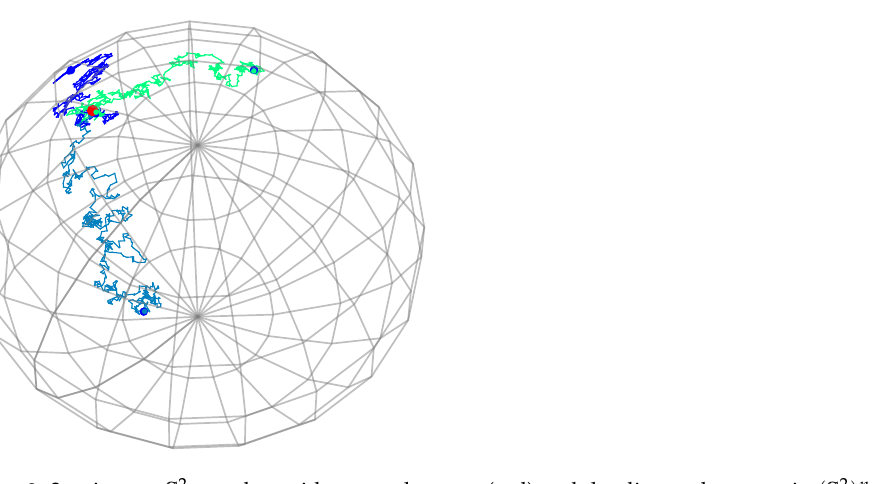
Figure 3. 3 points on S 2 together with a sample mean (red) and the diagonal process in ( S 2 ) n , n = 3 with T = 0.2 conditioned on the diagonal.